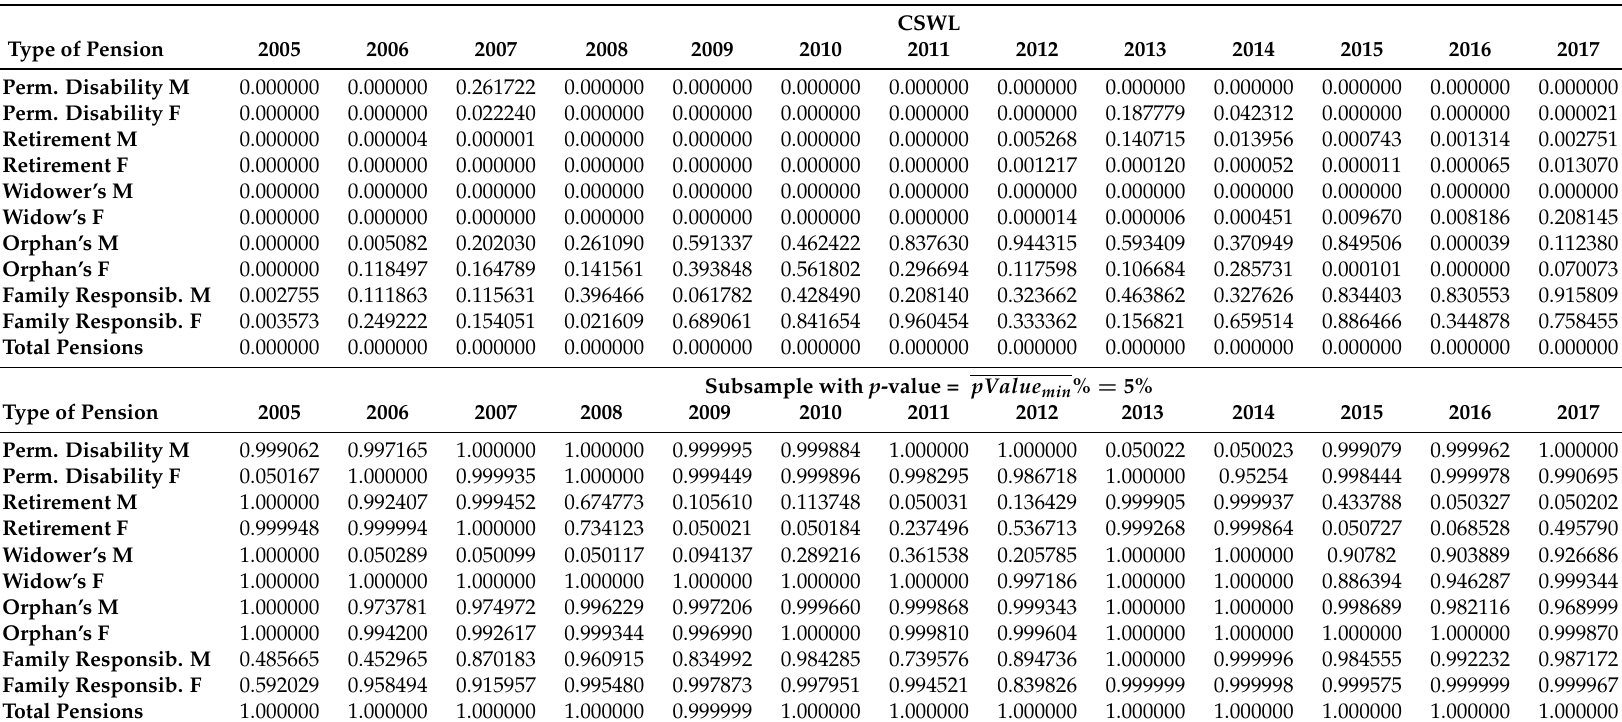
Table 3. Goodness-of-fit test (population/samples) p -values (CSWL and subsamples) M: Male; F: Female. Source: own.